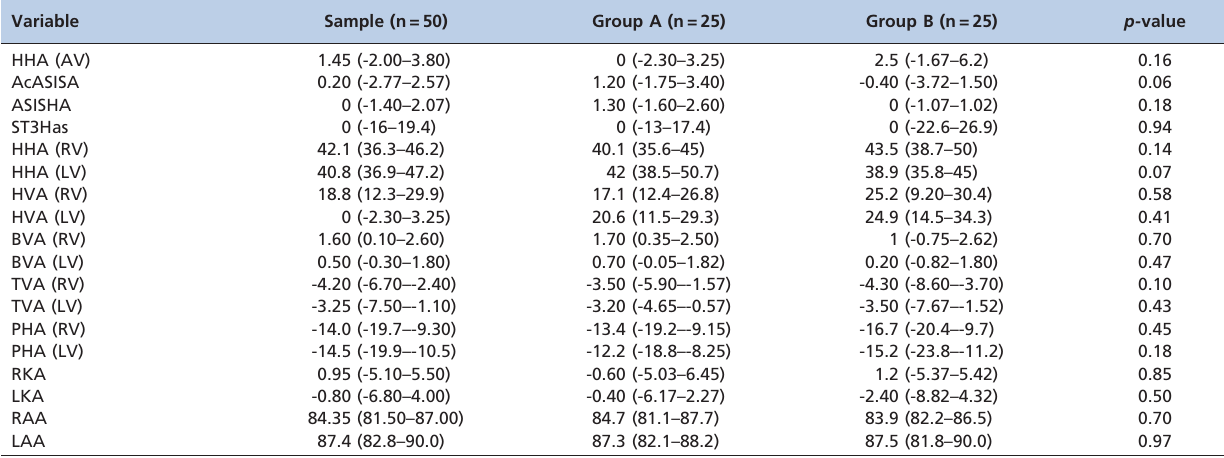
Table 3 - PAS values of the studied sample. Variable Sample (n=50)